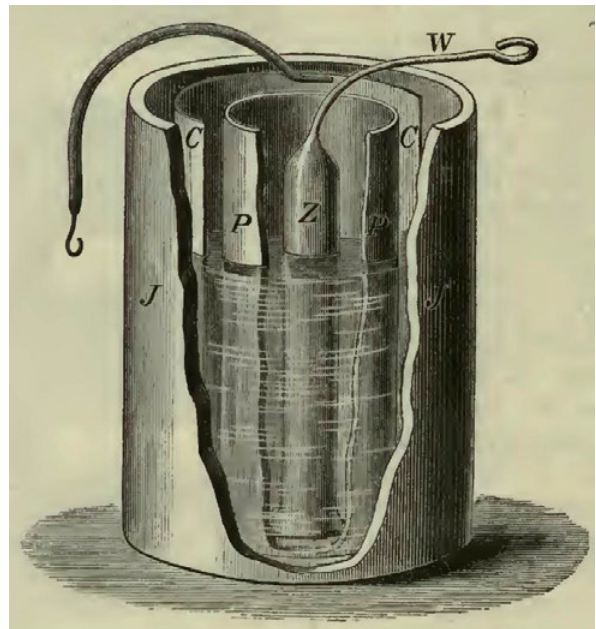
Figure 5. A drawing of a Daniell Cell. This later design utilizes a ceramic cell container and paper divider, with copper sheet and zinc rod